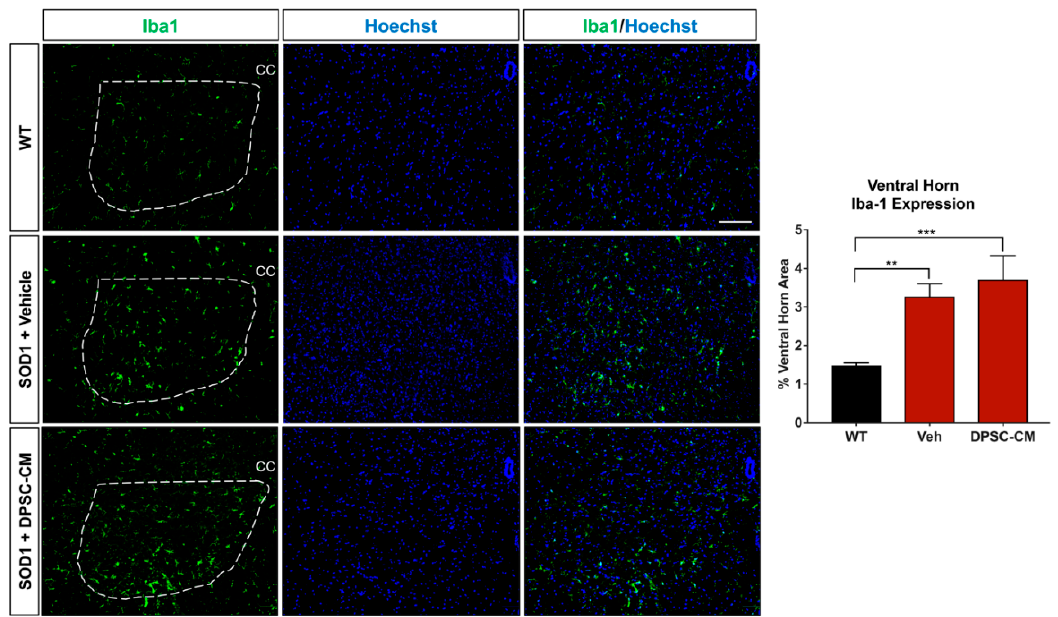
Figure 6. DPSC-CM therapy in the late pre-symptomatic period did not significantly alter lumbar ventral horn microglial reactivity. Microglial reactivity as measured by percent area of the ventral horn (dashed white line) occupied by Iba1+ labeling (green) was not significantly different between DPSC-CM and vehicle treated mSOD1 G93A mice at PD91. As with reactive astrogliosis, both treatment groups exhibited a similar significant elevation of microglial reactivity compared to WT mice. Data represent mean +/ − SEM. Data analyzed via one-way ANOVA. (WT, n = 3; mSOD1 G93A , n = 5–6). **, p < 0.01; ***, p < 0.001. CC = central canal. Scale bar = 100 µ m.